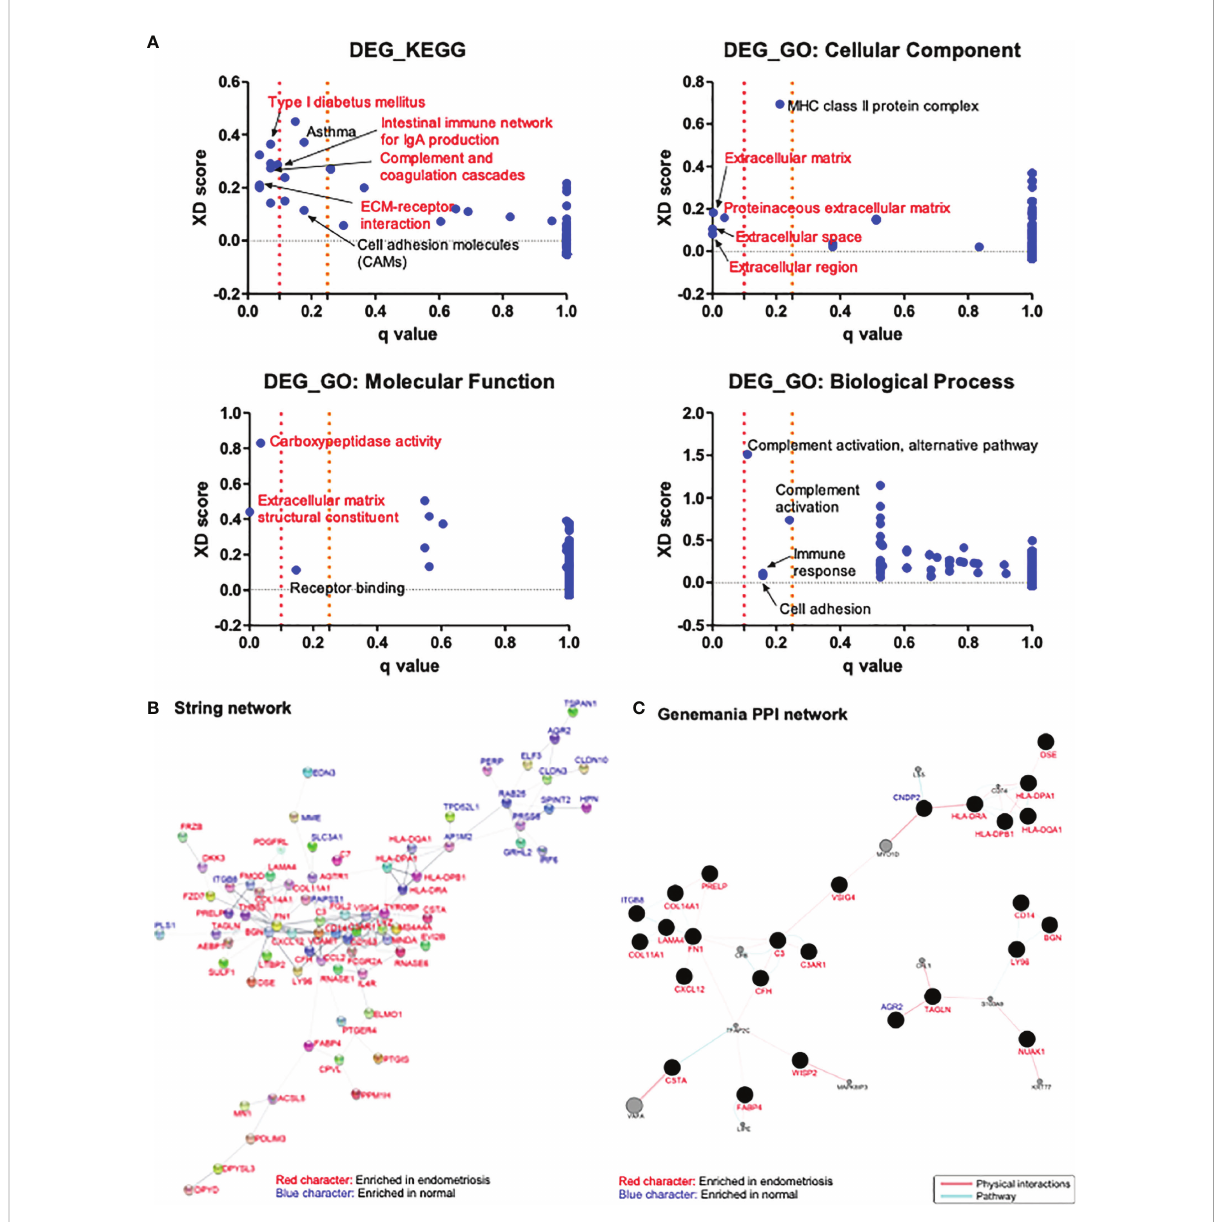
FIGURE 2 Analysis of the enriched pathways and interaction networks of DEGs in endometriosis. (A) KEGG and GO pathway analysis of DEGs from GSE11691, GSE23339, and GSE7305 datasets with Log2|FC| > 1 were performed with JEPETTO plugin of Cytoscape, and scatter plot were constructed with q -value and XD-score as x - and y-axis, respectively. Red character indicates the pathways with q -value < 0.1 and black character indicates the pathways with 0.1 < q -value < 0.25. (B, C) Protein – protein interaction network of DEGs from three datasets with Log2| FC| > 1 were analyzed in Cytoscape with plugins of STRING (B) and GeneMANIA (C) . Red character indicates genes enriched in endometriosis and blue character indicates genes enriched in